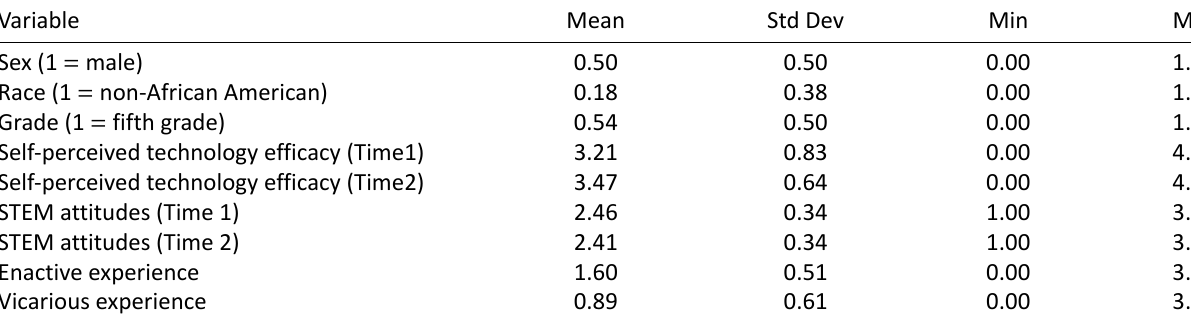
Table 1. Descriptive statistics of variables.